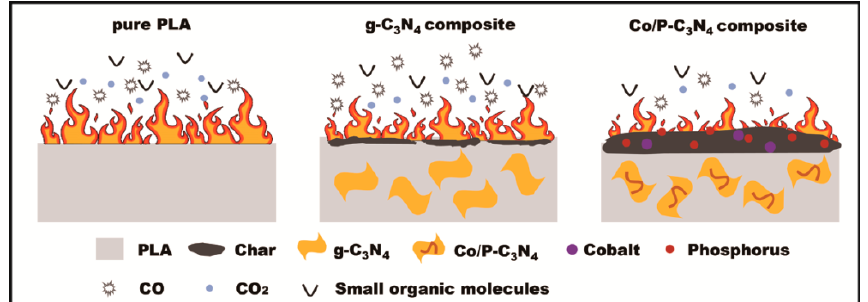
Figure 10. Schematic diagram of flame retardant mechanism of PLA composites.